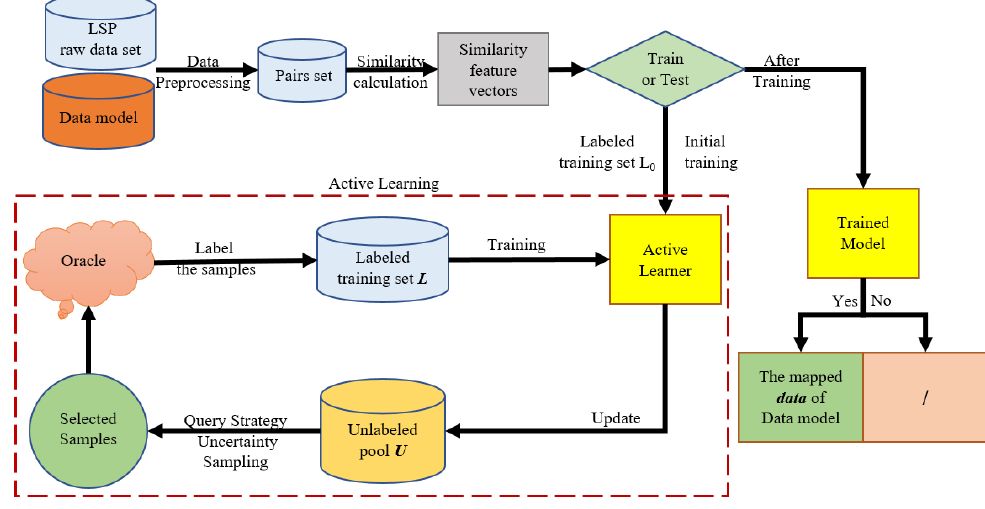
Figure 3. Active-learning